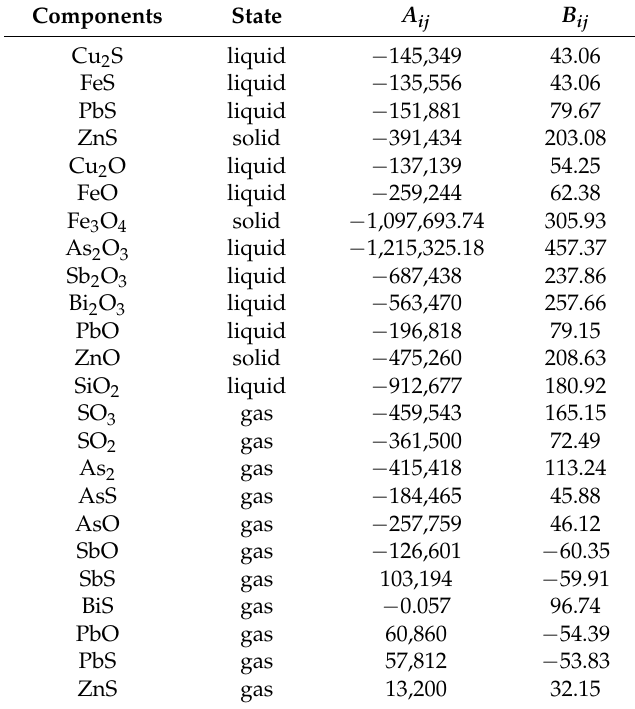
Table 3. Standard Gibbs free energy (J · mol − 1 ) of formation of each